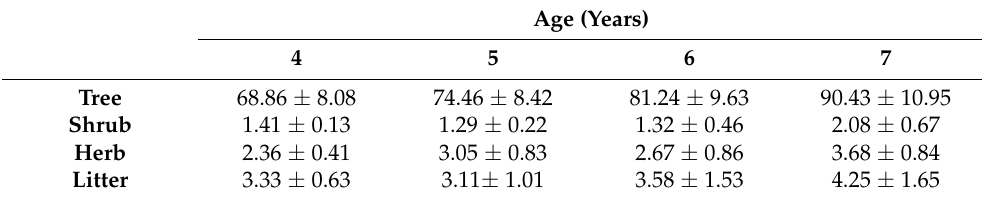
Table 4. Biomass (Mg ha − 1 ) of vegetation of D. latifolia plantation of different ages: (a) 4 years